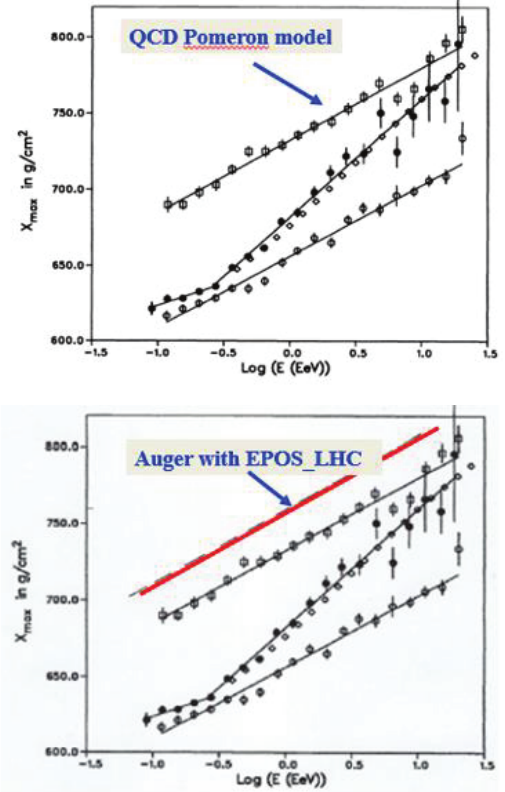
Fig.2. Data from [6] are shown in both plots. The different conclusions that can be drawn according to which model is adopted are evident (see discussion in text).